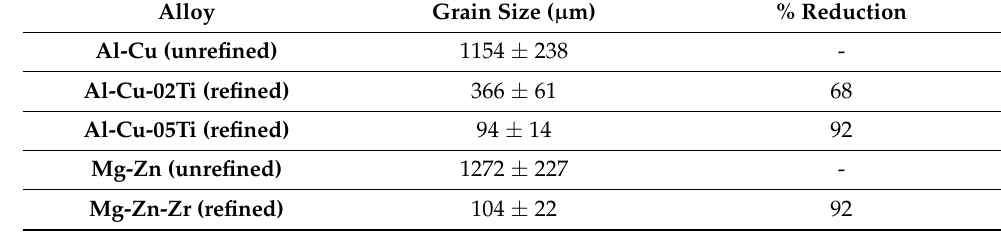
Table 2. Grain sizes of unrefined and refined Al-Cu and Mg-Zn alloys.